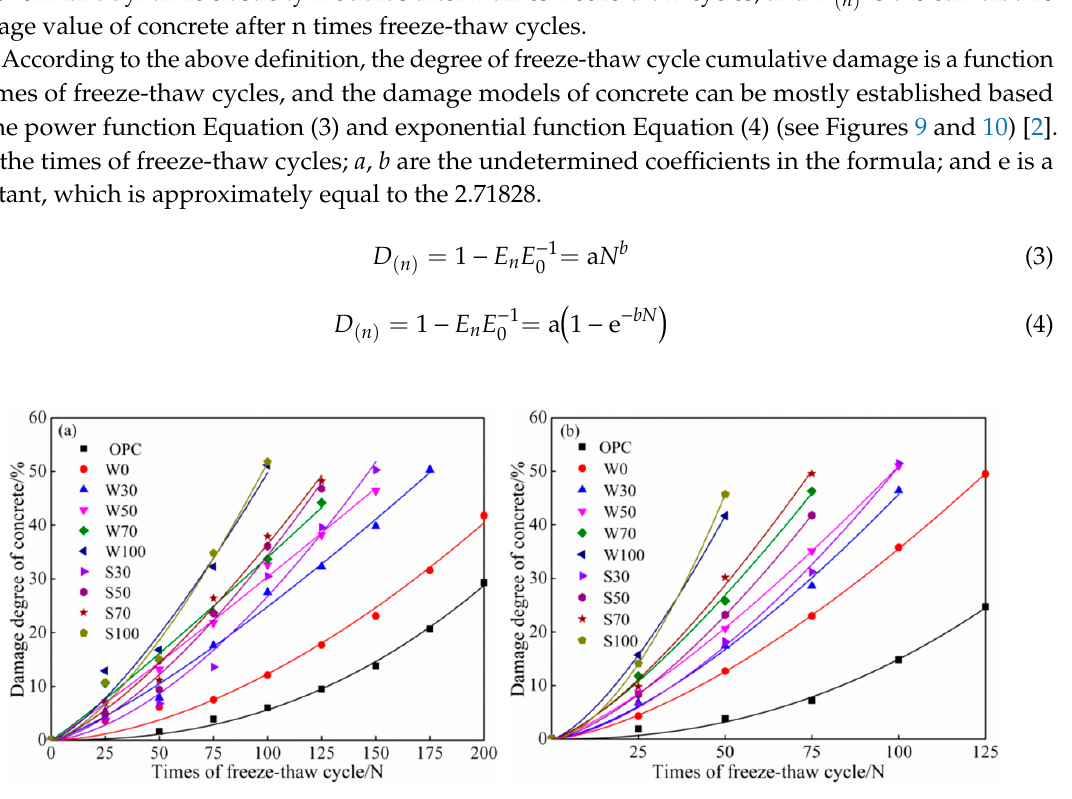
Figure 9. Accumulative freeze-thaw damage power function model of ( a ) water freeze-thaw cycle and ( b ) salt freeze-thaw cycle of alkali-activated coal gangue-slag concrete (ACSC).